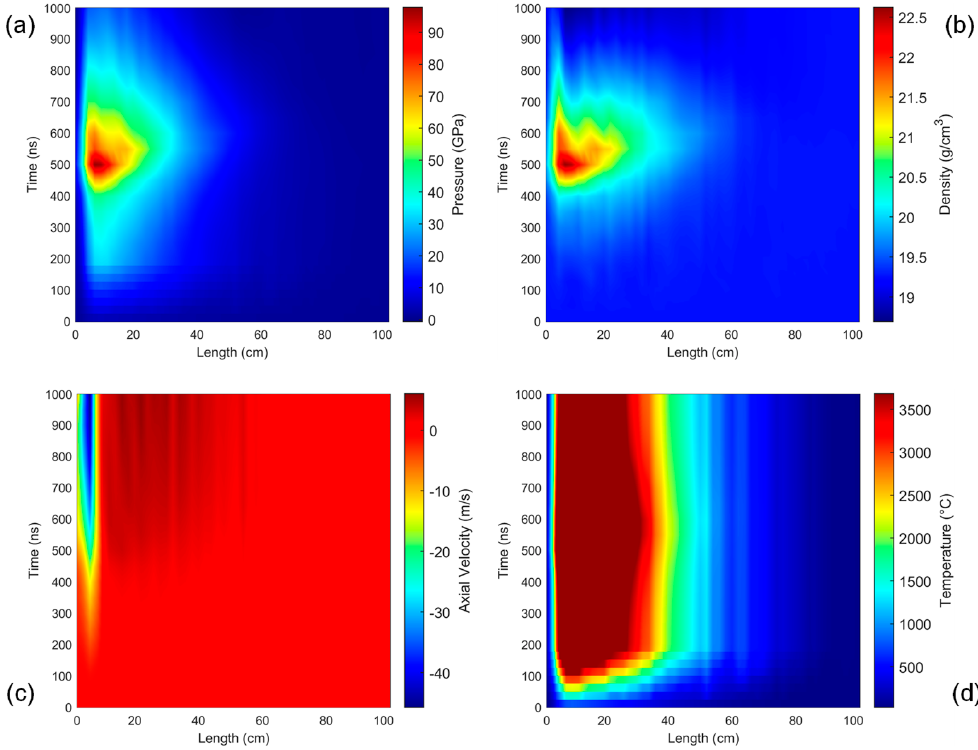
Figure 12. Pressure ( a ), density ( b ), particle velocity in axial direction ( c ), and temperature ( d ) distributions at the radial position of 2.5 mm (R 2.5 of Figure 5).